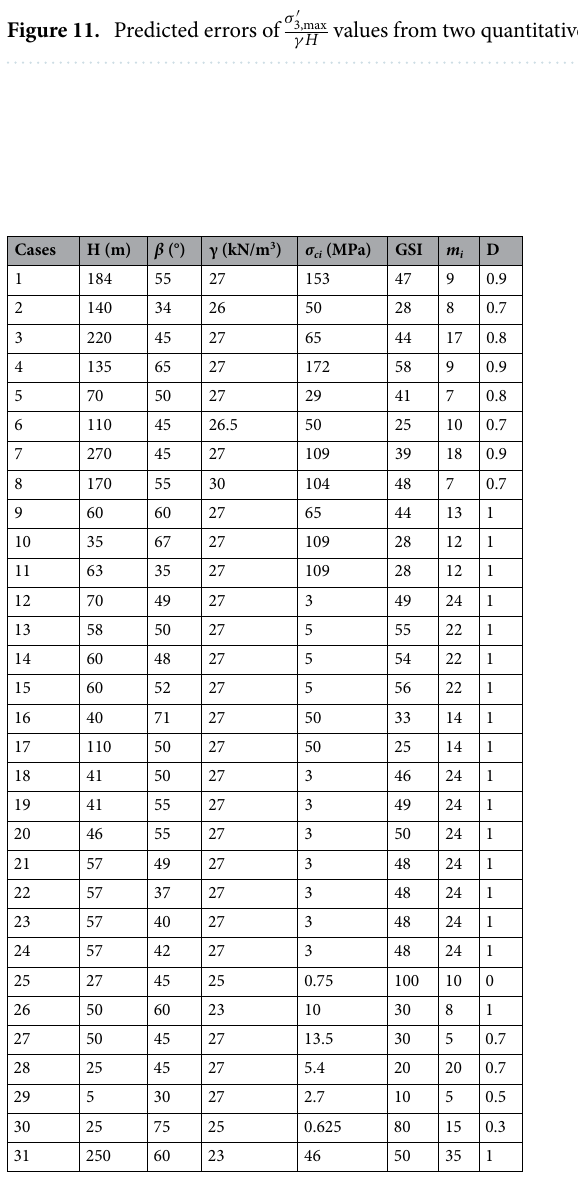
Figure 11. Predicted errors of